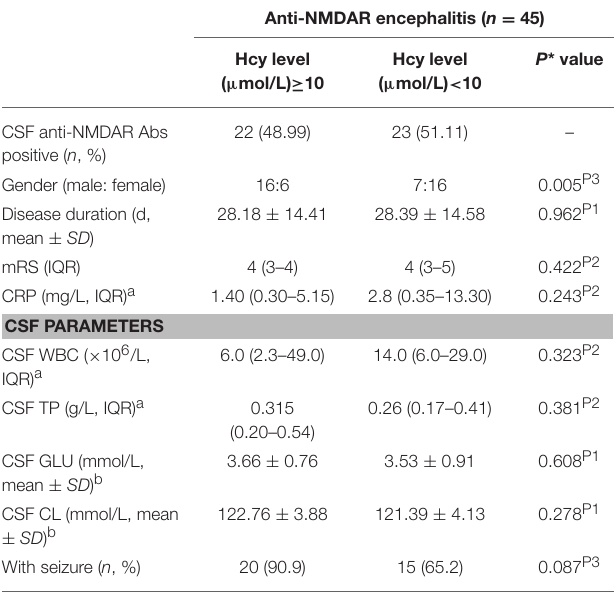
TABLE 2 | Plasma Hcy levels in patients with anti–NMDAR encephalitis. Variables